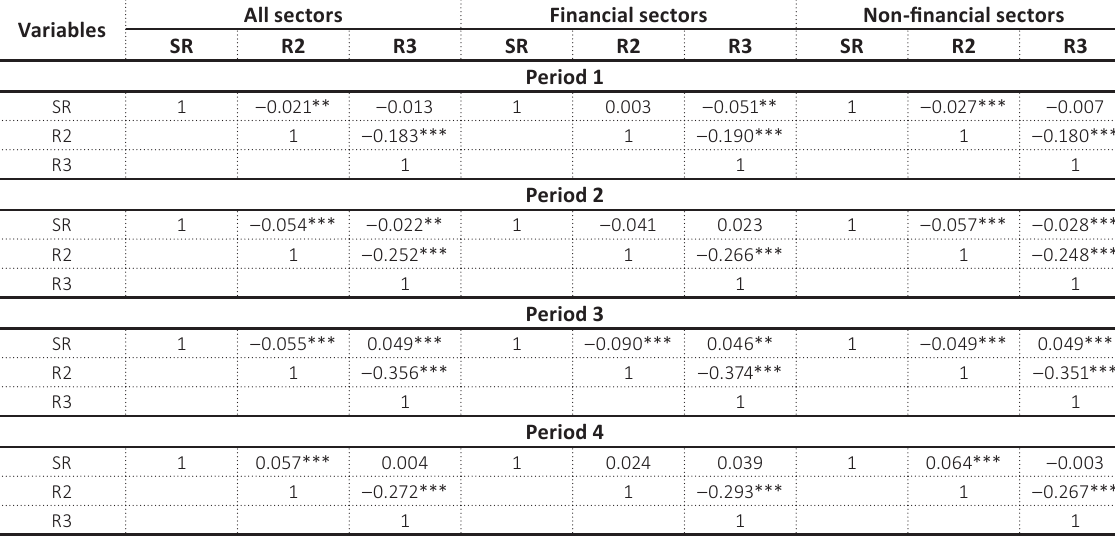
Table 3. Correlation analysis (systematic risk is the coefficient of determination) Variables